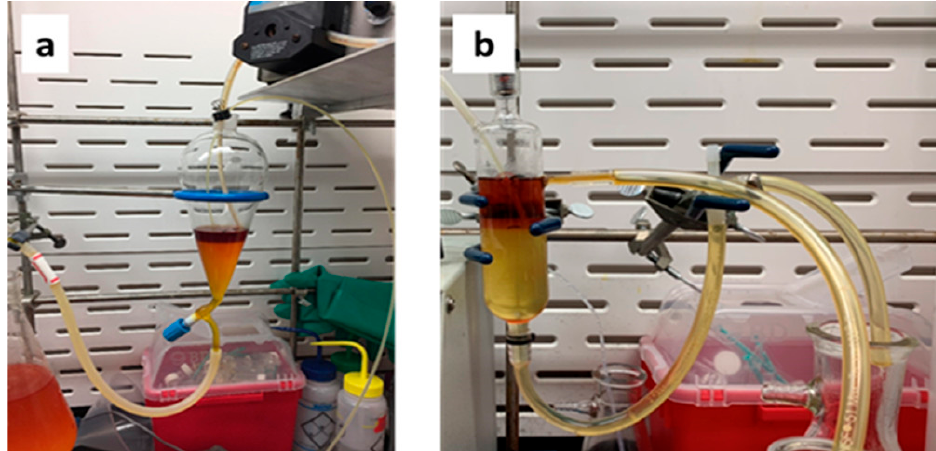
Figure 4. Two gravity separators used in the CLLE step. ( a ) Separatory funnel with pumping out of the organic layer into a different vessel. ( b ) Custom gravity separator with an organic overflow egress to different vessel. Reprinted with permission from ref. [85]. Copyright 2021, American Chemical Society.